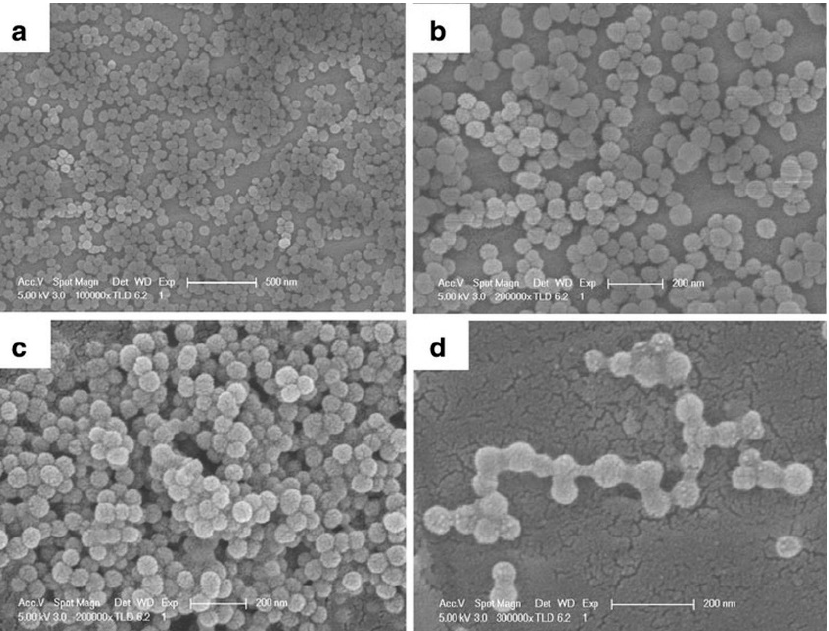
Figure 3. SEM images of pristine SiO 2 ( a , b ) and SiO 2 - g -P(DMAEMA-Q) ( c , d ). Reproduced with permission from reference [70].